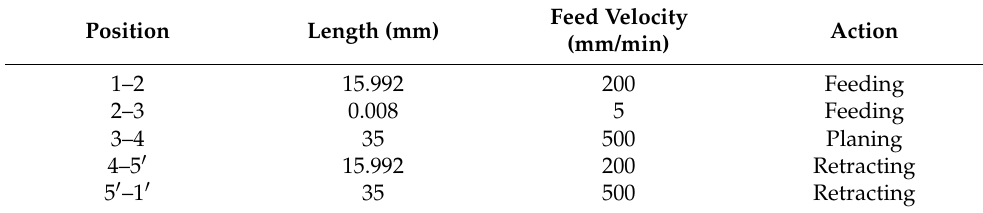
Table 2. Parameters of diamond